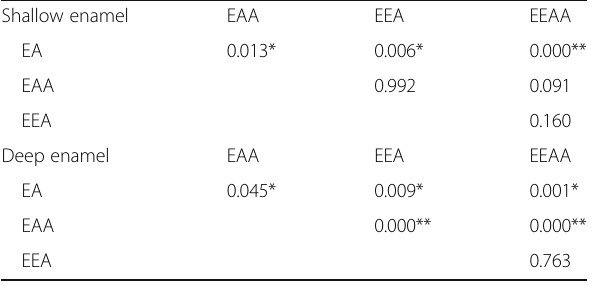
Table 5 Multiple comparisons for the mean Δ E (T2-T0) between the different resin infiltration protocols in the shallow and deep dentine